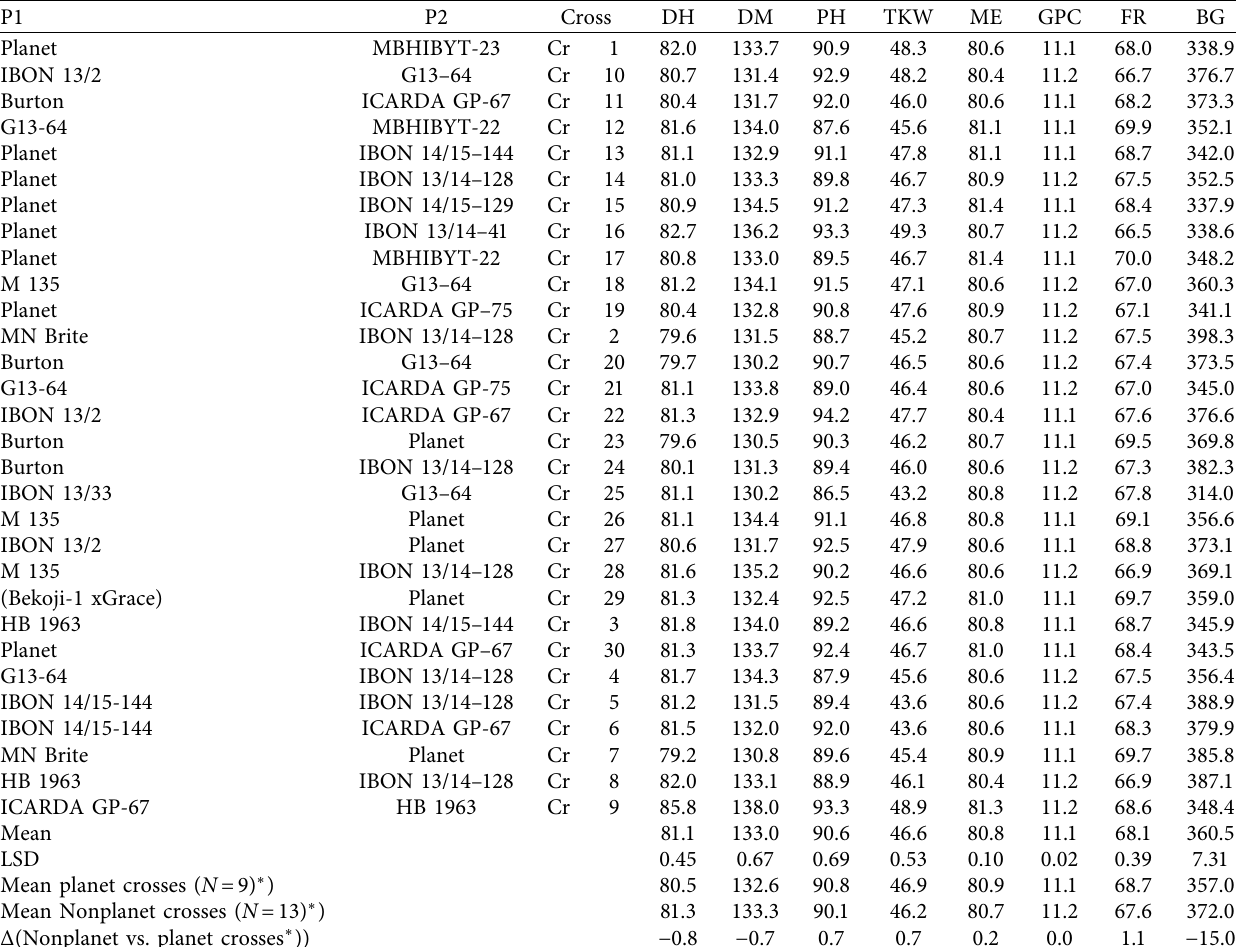
Table 4: BLUP predicted mid-parent values across two environments.